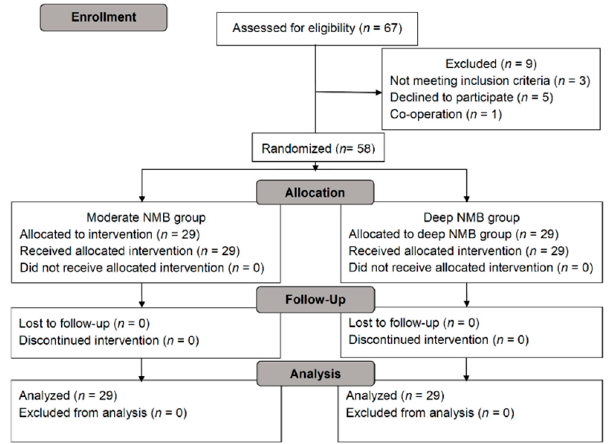
Figure 1. Consort flow diagram of the patients. Table 1. Characteristics of patients, surgery and anesthesia.